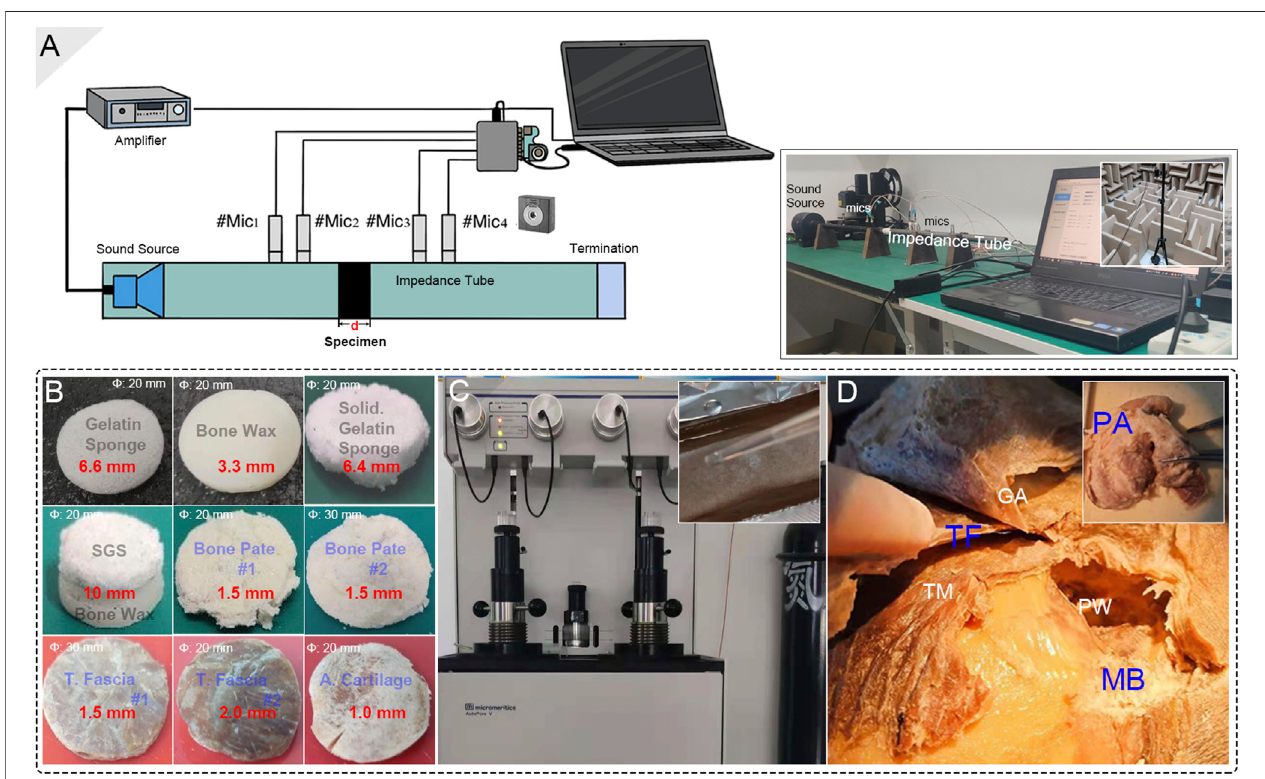
FIGURE 3 | Biomaterial preparation and setup of the acoustical impedance investigation. (A) The schematic diagram of the impedance tube system setup. Notice thatthedeployedacousticsensorswereproperly calibrated beforeeachacoustical testusingacalibratingdeviceinananechoicroom. (B) The fi naltestingbiomaterials. Thediameterandthicknessofthematerialsaremarkedinwhiteandredcolors,respectively. (C) Themercuryporosimeter andthemakingofasolidi fi ed-gelatinsponge. (D) The tested graft materials, i.e., bone pate, temporalis fascia, and auricular cartilage, were harvested from the cadaveric head. PA, TF, and MB indicate postauricular cartilage, temporalis fascia, and mastoid bone, respectively. GA, TM, and PW indicate galea aponeurotica, temporalis muscle, and posterior wall of the external auditory